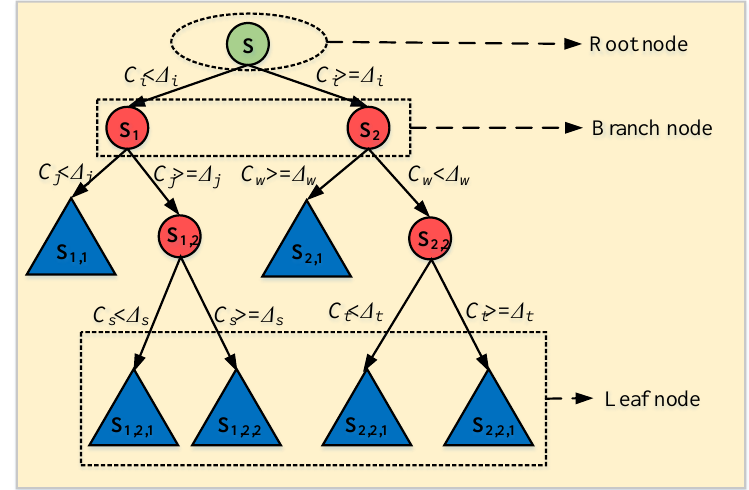
Figure 7. Model representation as a binary tree.